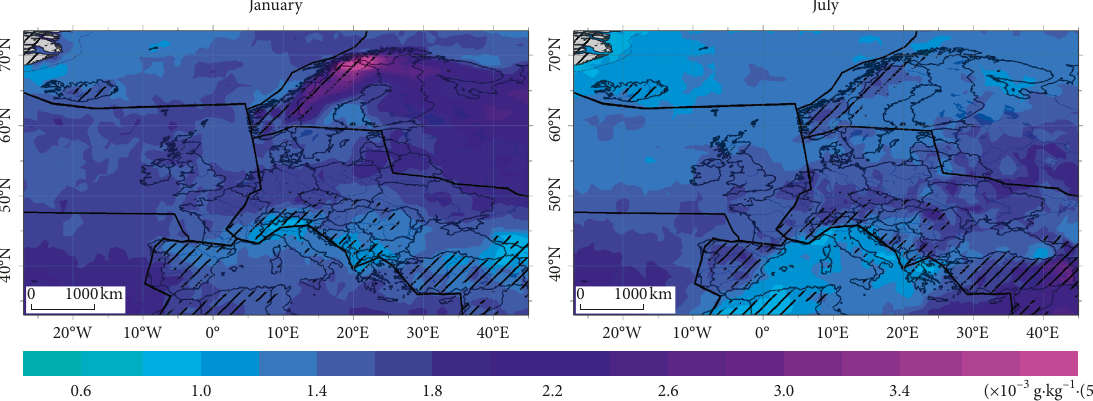
1 1 ) (1981–2015); slanted lines are used to denote areas situated kg (50 hPa) · · − −